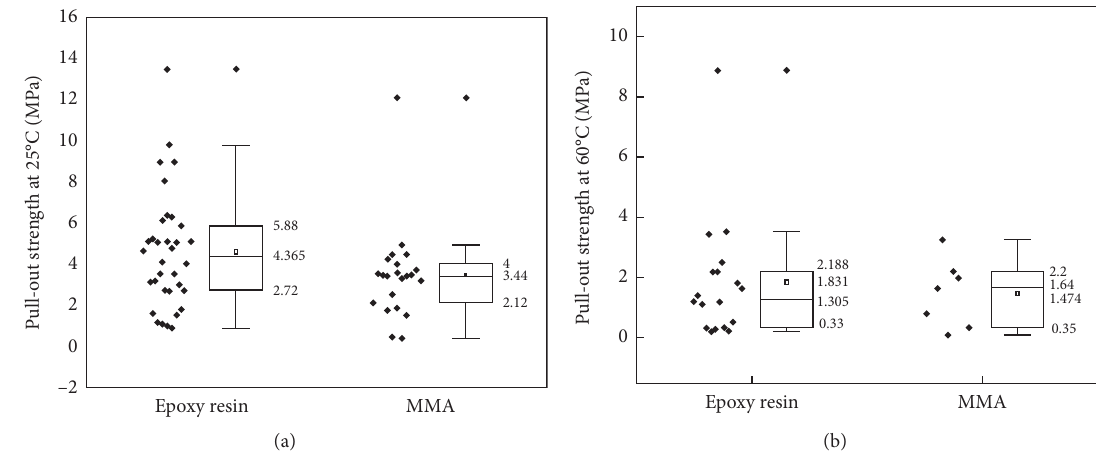
Figure 13: Pull-out strength comparison of resin waterproof adhesive layer: (a) pull-out strength at 25 ° C; (b) pull-out strength at 60 ° C.